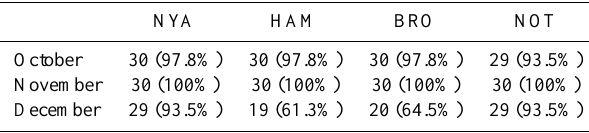
Table 2. Available days of data of each receiver for each months: the corresponding percentage is in open